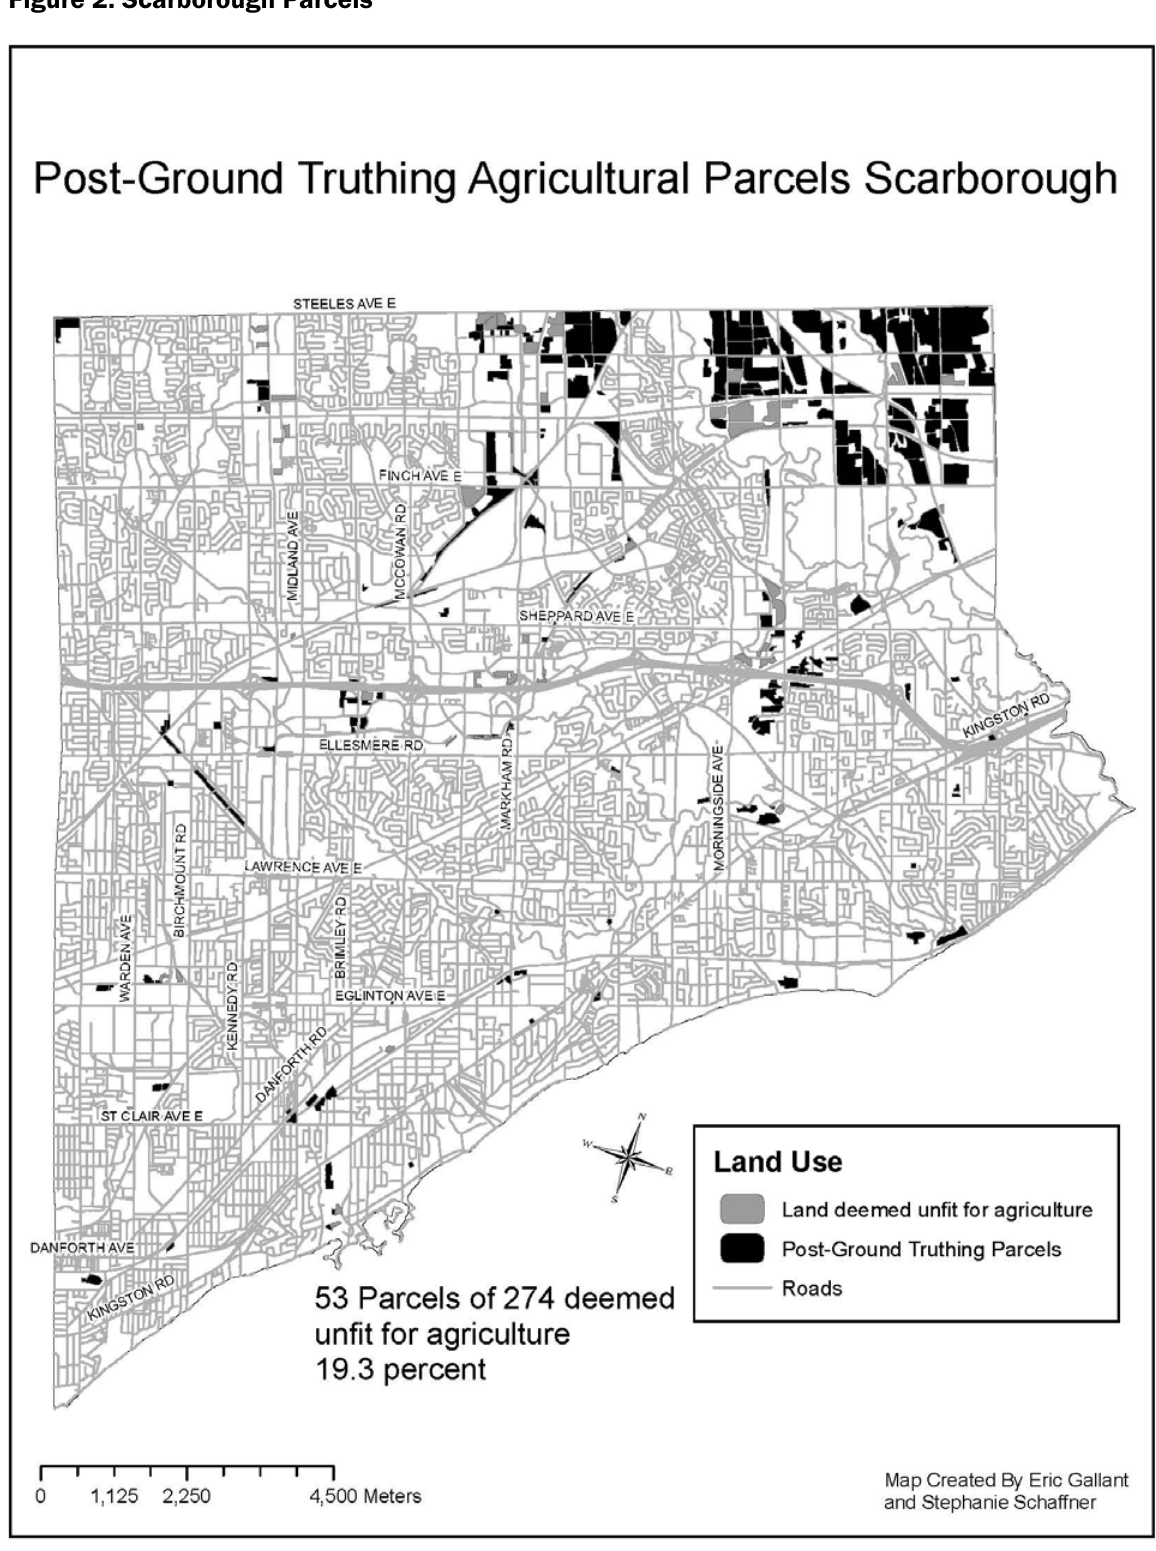
Figure 2. Scarborough